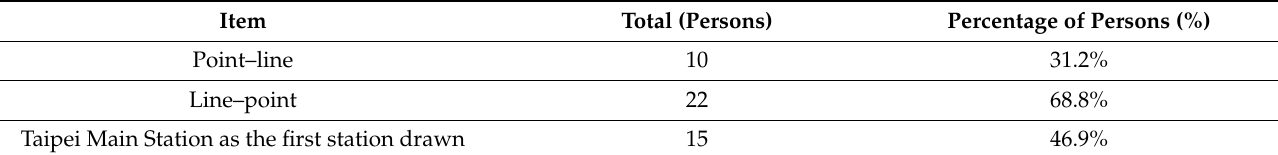
Table 1. Statistical results for drawing order.